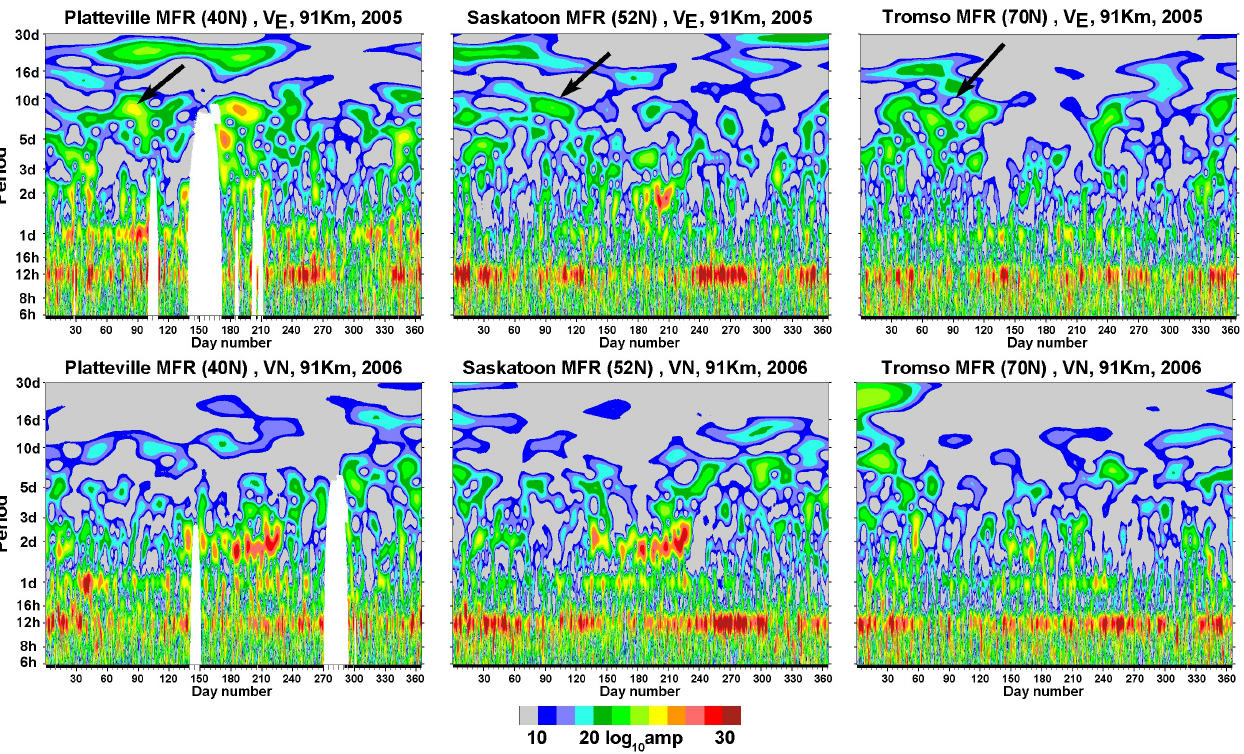
Fig. 5. Wavelets of zonal radar winds for 2005 at 91 km for Platteville (40 ◦ N, 105 ◦ W), Saskatoon(52 ◦ N, 107 ◦ W), and Tromsø (70 ◦ N, 19 ◦ E). Overplotted arrows show where the 8d wave should appear. The colour scale is dB (20 log 10 Amp ). Meridional wind wavelets for 2006 are